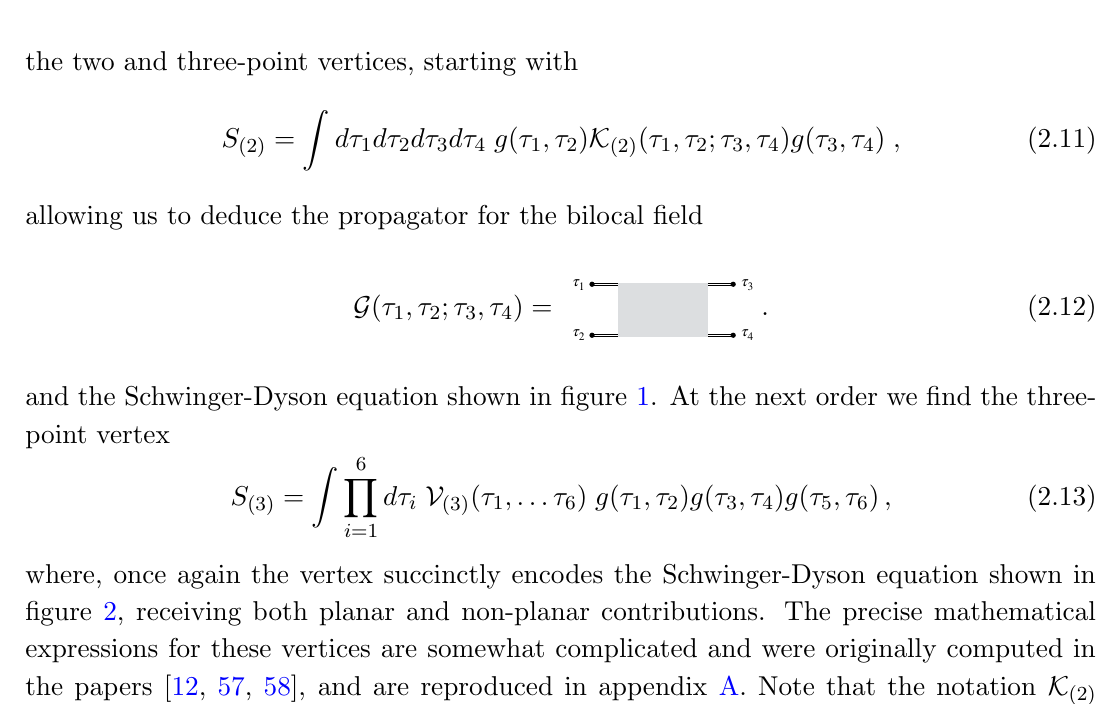
Figure 2 . Schwinger-Dyson equation determining the three-point vertex are two kinds of contributions on the right-hand side, planar ones and non-planar ones. For the theory formulated in terms of Majorana fermions this is a six-point